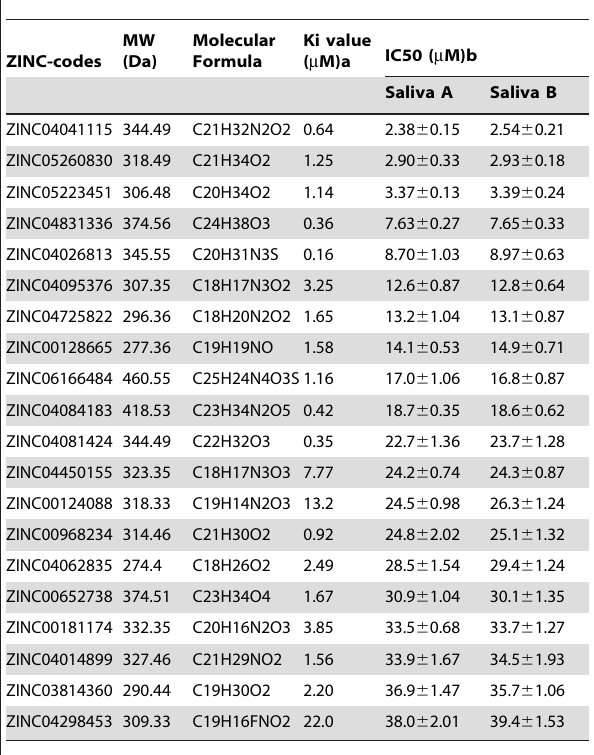
Table 3. The basic features of the 20 most inhibitory lead-like